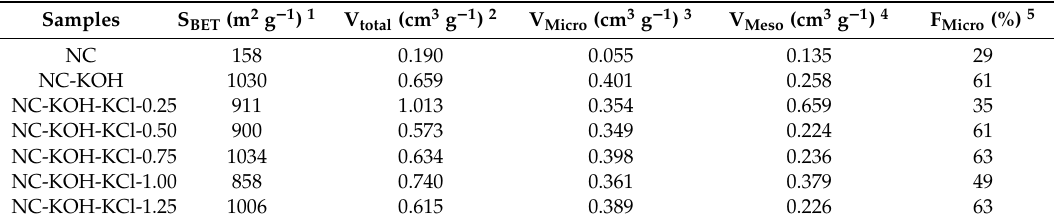
Table 2. BET surface area and porosity of samples activated by di ff erent amount of KCl and 1.2 g KOH per 2.20 g resorcinol.